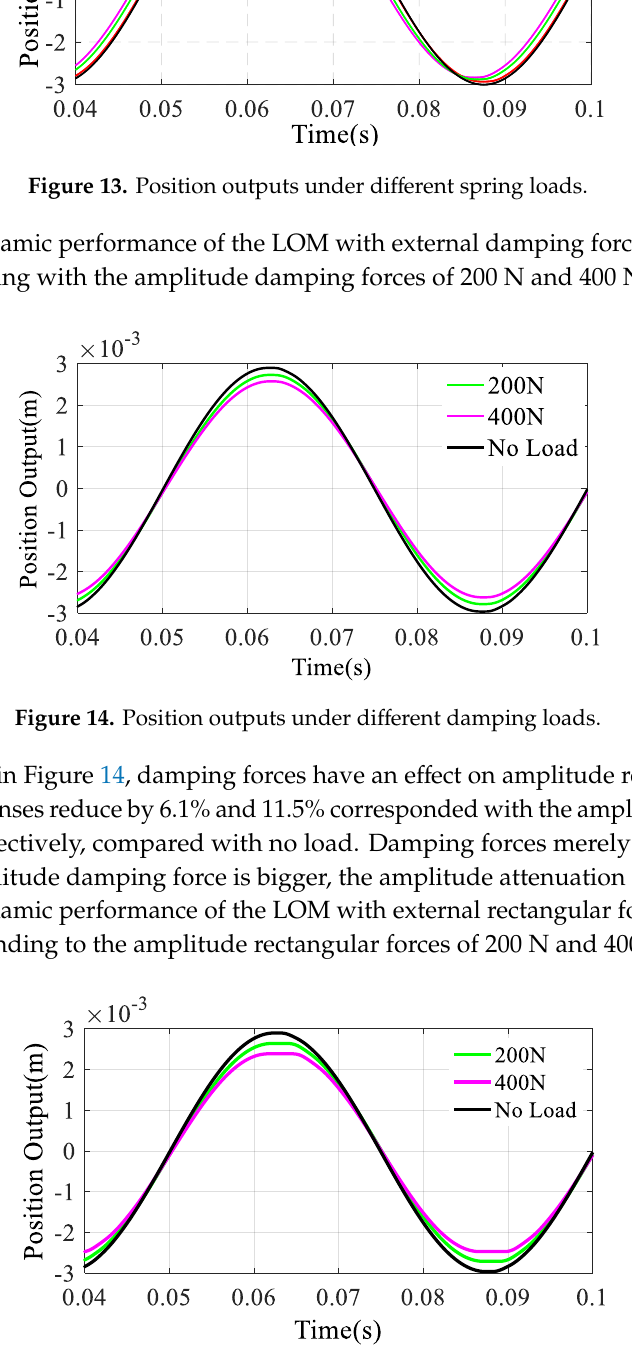
Figure 15. Position outputs under different rectangular loads.